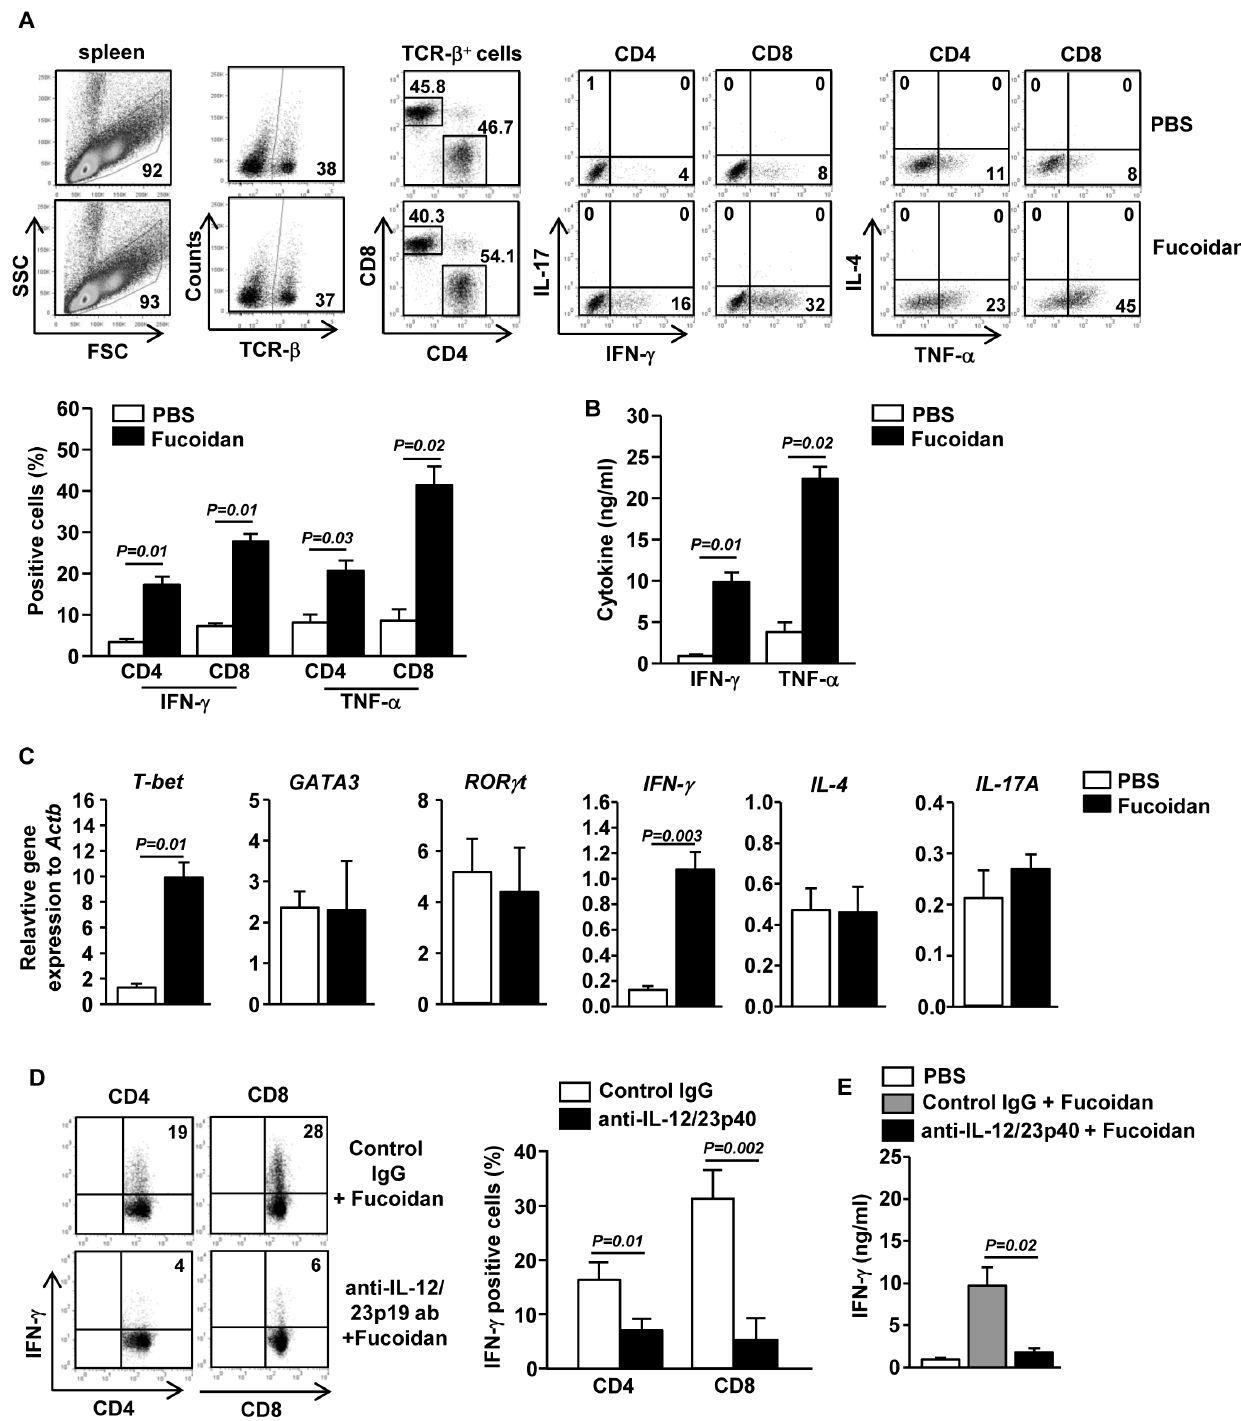
Figure 3. Fucoidan-induced cDC maturation promotes generation of IFN- c -producing T cells in an IL-12 dependent manner. C57BL/6 mice were injected i.p . with 10 mg/kg fucoidan and 3 days later, injected again with same amount of fucoidan. (A) Percentage of IFN- c , IL-17, IL-4 and TNF- a positive cells within CD4 and CD8 T cells in spleen was assessed by flow cytometric analysis (upper panel). Percentage of IFN- c + or TNF- a + cells (lower panel). (B) IFN- c and TNF- a levels in serum. All data are representative of or the average of analyses of 6 independent samples (2 mice per experiment, total 3 independent experiments). (C) Gene expression in spleens was measured 24 hrs after fucoidan injection. Data are the average of analyses of 6 independent samples (2 mice per experiment, total 3 independent experiments). (D) Fucoidan was injected to C57BL/6 mice in conjunction with a neutralizing anti-IL-12/23p40 antibody or control rat IgG and the same injections were repeated 3 day later. Intracellular IFN- c expressions in CD4 or CD8 T cells from these mice were analyzed on a flow cytometer. (E) Serum IFN- c levels from mice described in (D). All data are representative of 6 samples from 3 independent experiments.